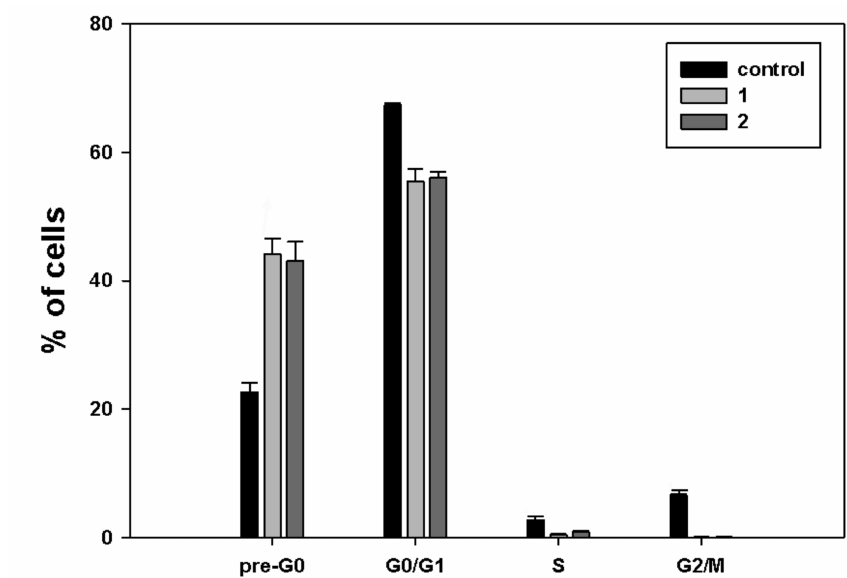
Figure 3. Cell cycle distribution of MDA-MB-231 cells exposed to 1 and 2 , compared to control conditions. The results are expressed as the mean ± SEM. of triplicate assays. Four replicates were run for each assay. All p values were <0.05 if compared to